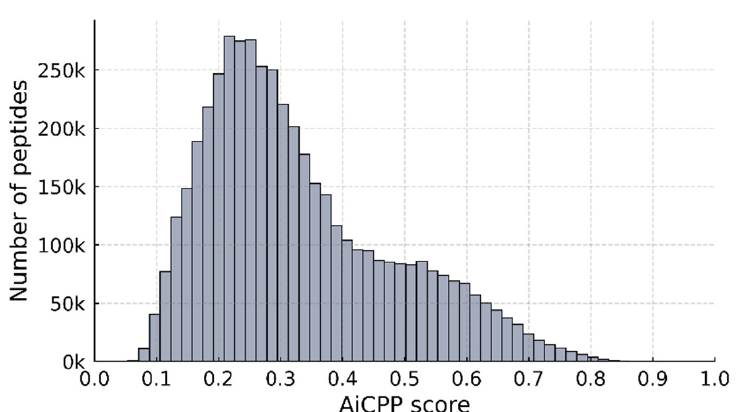
Figure 7. Histogram of AiCPP scores for mutant peptides predicted by the AiCPP model. The X -axis represents the AiCPP score, and the Y -axis represents the number of peptides with that AiCPP score. X -axis, while the Y -axis indicates the frequency of amino acid occurrence. Sequences with 4, and 14, corresponding to P, G, and T,